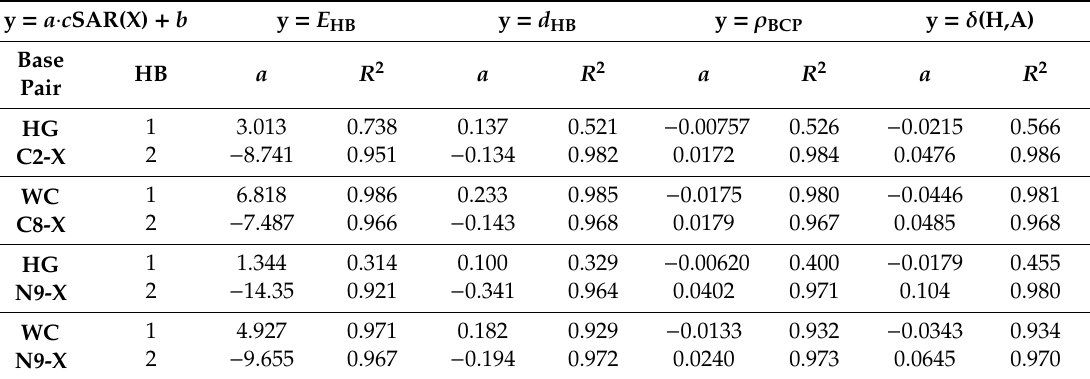
Figure 4. Dependence of the HB1 and HB2 energies on cSAR(X) for the WC and HG base pairs substituted at ( a ) C8 and C2 and ( b ) N9 positions of the adenine moiety. Table 2. Slopes of the obtained linear relations between the H-bond descriptors (y) and c SAR(X), and the determination coefficients ( R 2 ) for the substituted WC and HG base pairs.